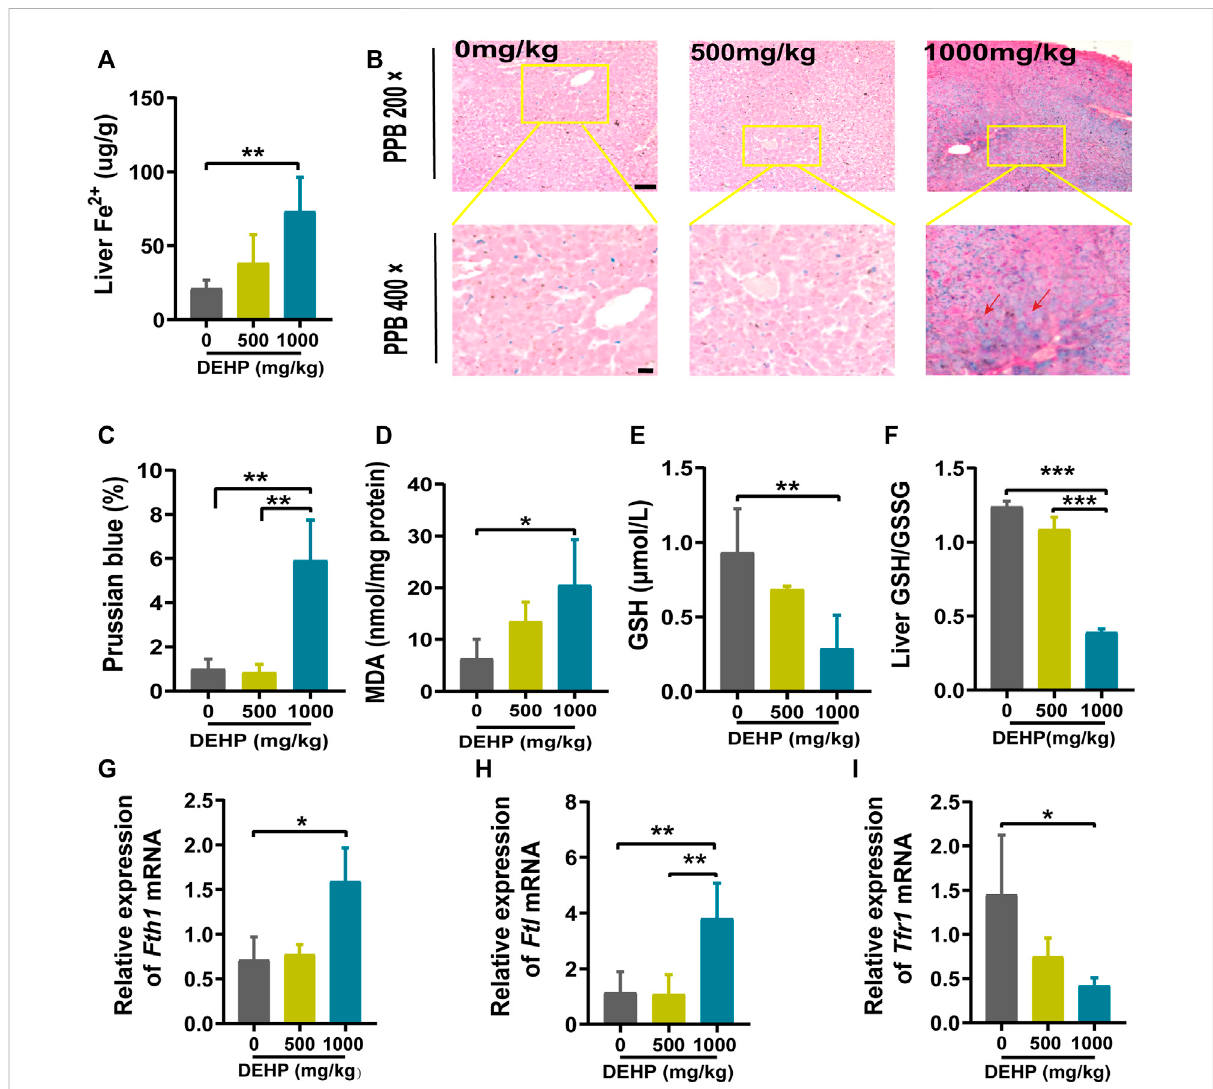
FIGURE 2 DEHP exposure disrupted iron metabolism and increased oxidative stress in mice livers. (A) The level of Fe 2+ in the liver. (B) Representative micrographs from PPB staining. First row, 200× (scale bar = 100 μ m); second row, 400× (scale bar = 50 μ m). The red arrow indicates the accumulation of iron in the liver tissue. (C) Quanti fi cation of PPB staining for iron in hepatocytes. (D) MDA content in the livers of mice. (E) GSH content in the livers of mice. (F) Liver GSH/GSSG ratio. (G – I) RT ‒ qPCR of the iron metabolism-related genes Fth1, Ftl, and Tfr1 in mouse livers. Data are presented as the mean ± SD. PPB, Perl ’ s Prussian blue; MDA, malondialdehyde; GSH, glutathione. * p < 0.05, ** p < 0.01, *** p <